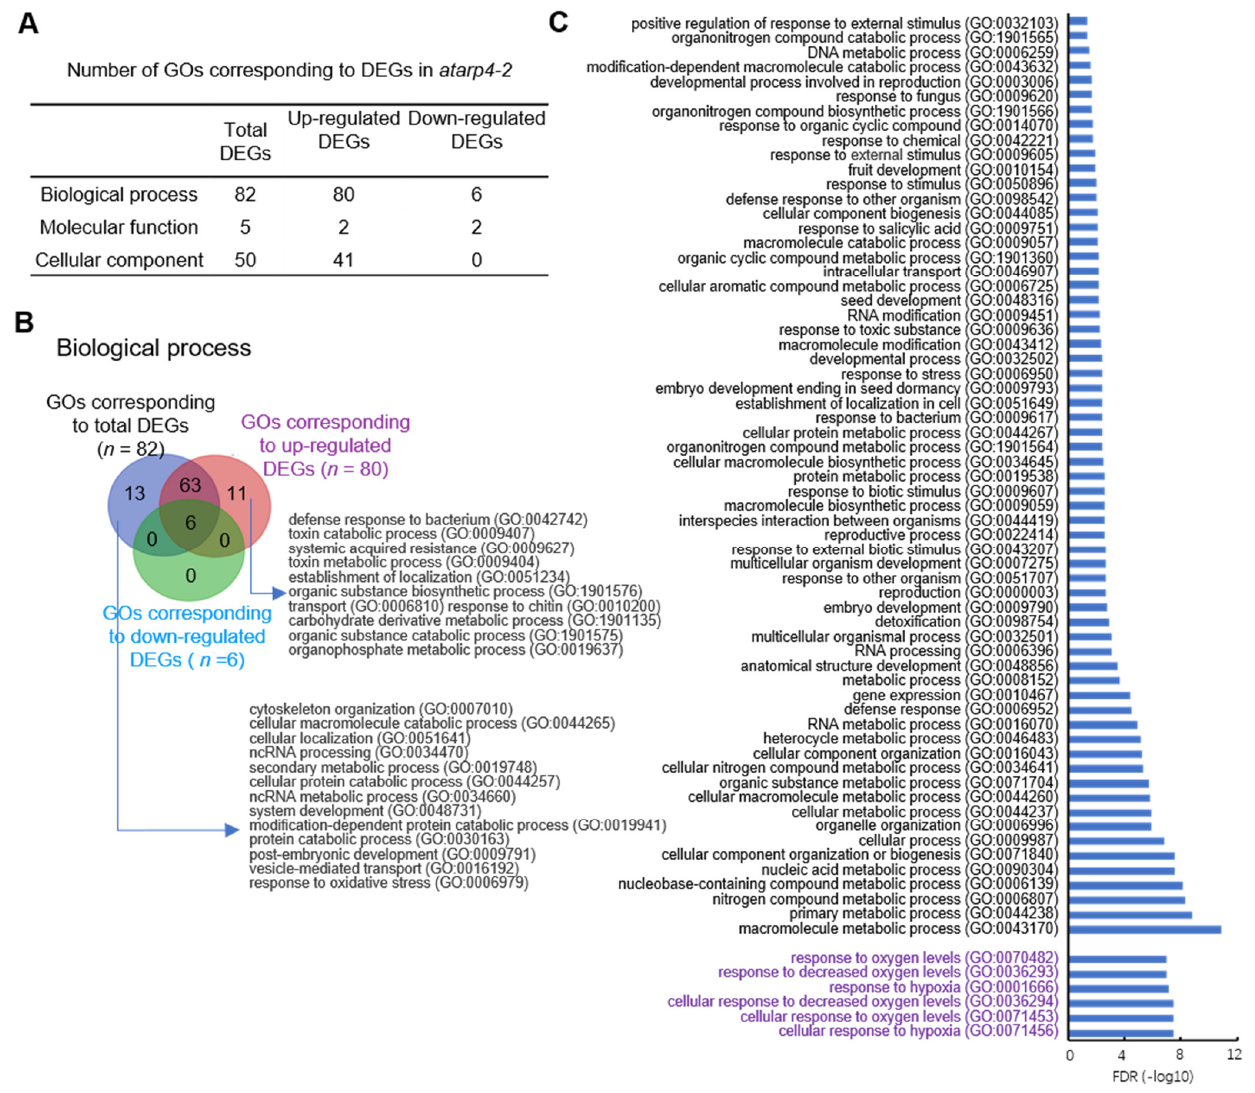
Figure 4. Functional enrichment analysis of DEGs caused by mutation of AtARP4. ( A ) The number of DEGs-based GOs corresponding to biological processes, molecular functions and cellular components in atarp4-2. ( B ) The overlap of enriched GOs corresponding to total, up-regulated and down-regulated DEGs in biological process. The detailed GOs were displayed in each subset. ( C ) Significantly enriched GOs shared by total DEGs and up-regulated DEGs in ( B ). The GOs shared by total-DEGs, up-regulated DEGs, and down-regulated DEGs are highlighted by purple.